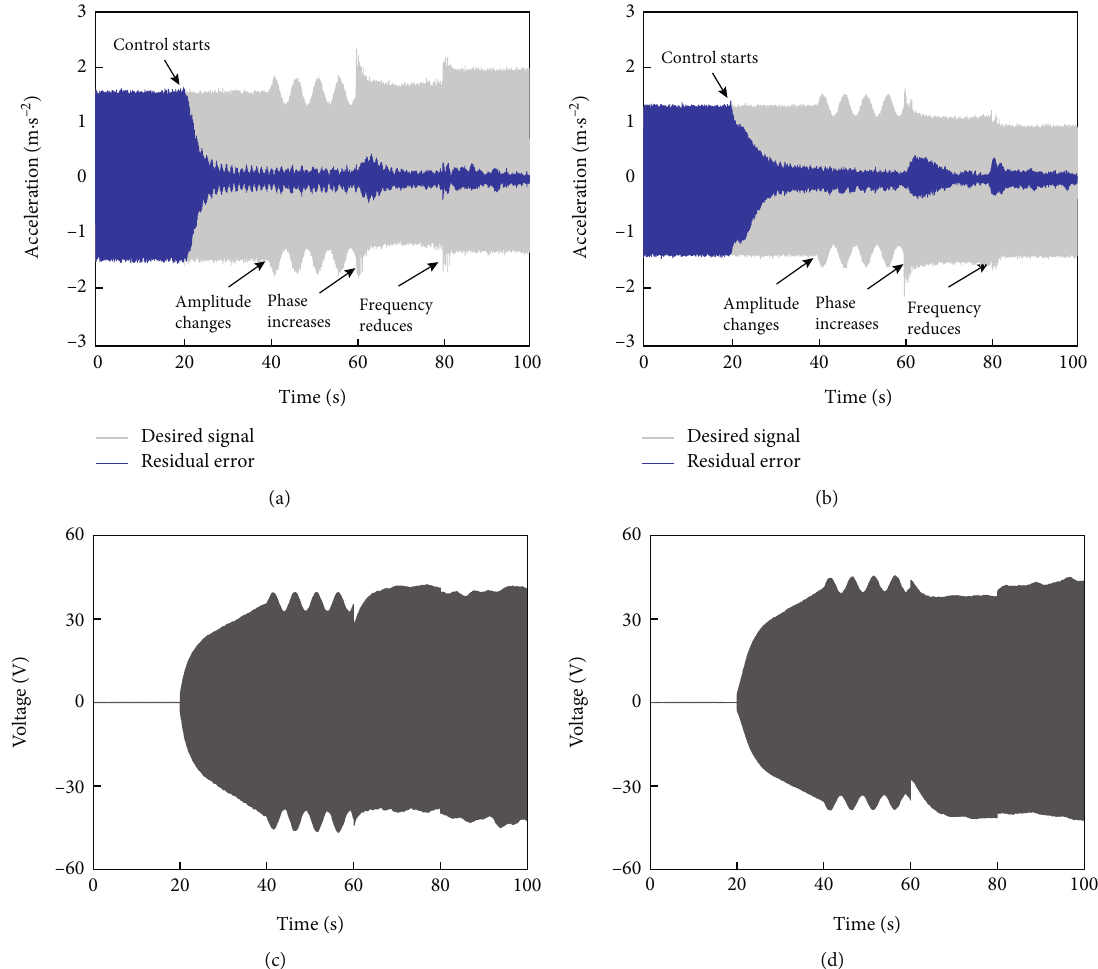
Figure 18: Acceleration response and control voltage with LMS-IOBR. (a) Acceleration response at 1# point. (b) Acceleration response at 2# point. (c) Control voltage of 1# PSA. (d) Control voltage of 2# PSA.